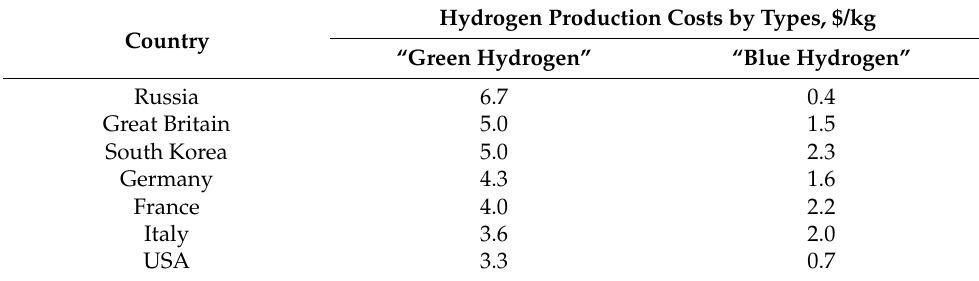
Table 1. Costs of hydrogen production by different technologies by country, 2019. Hydrogen Production Costs by Types, $/kg Country “Green Hydrogen” “Blue Hydrogen” Russia 6.7 0.4 Great Britain 5.0 1.5 South Korea 5.0 2.3 Germany 4.3 1.6 France 4.0 2.2 Italy 3.6 2.0 USA 3.3